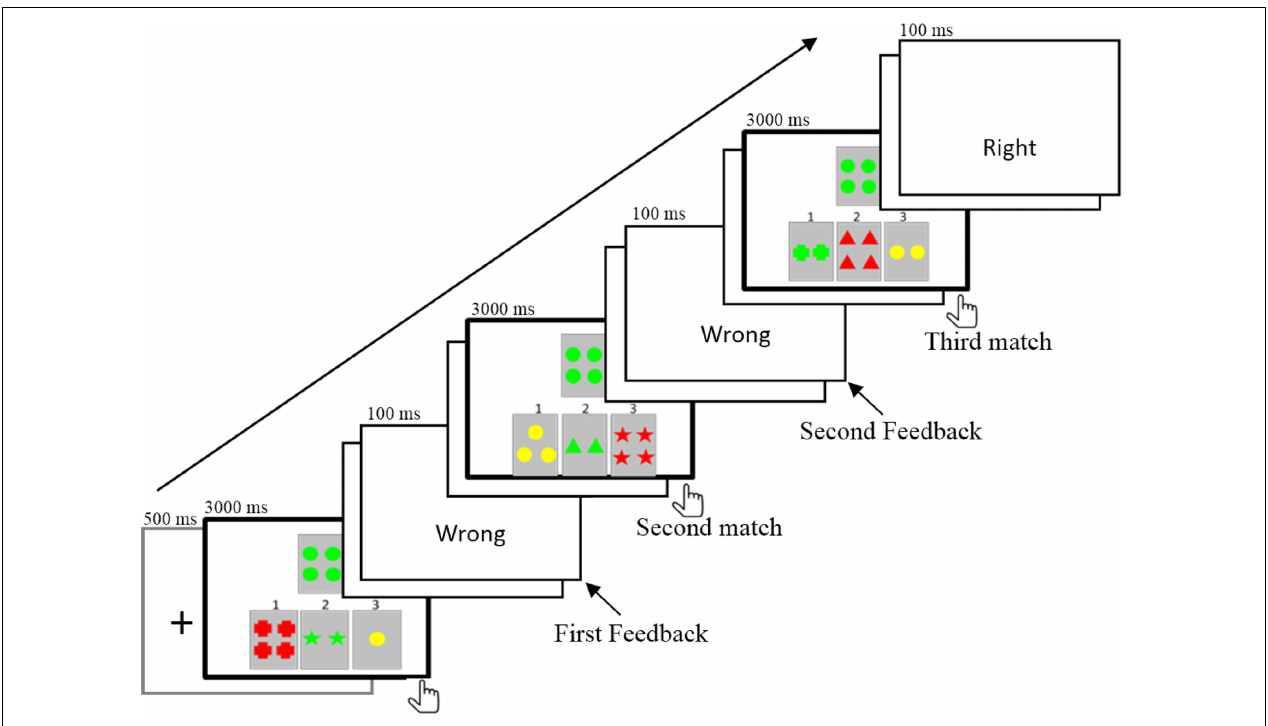
FIGURE 1 | The procedure and the locations of feedback for each